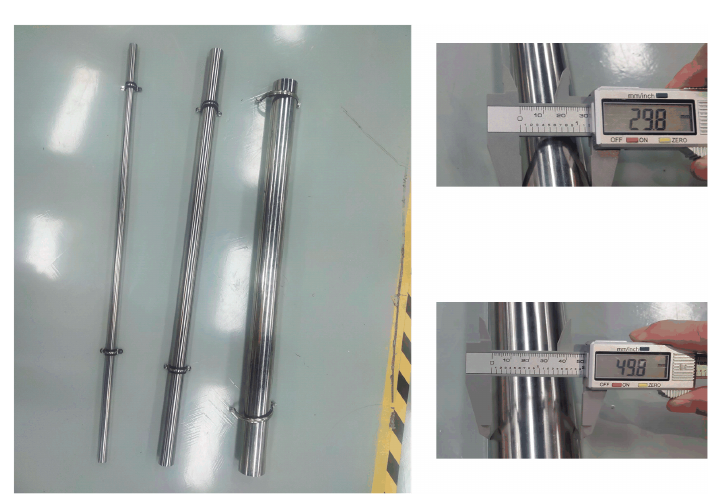
Figure 7. Installation position of the cylinder.